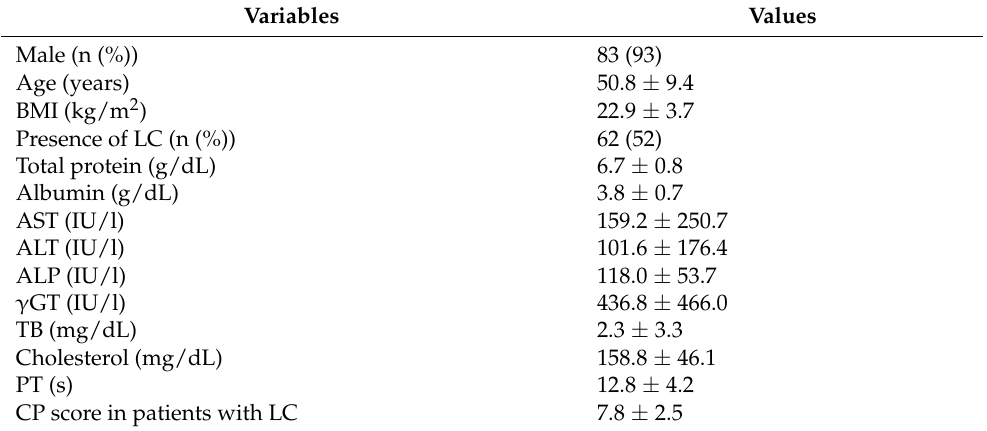
Table 1. Patients’ clinical baseline